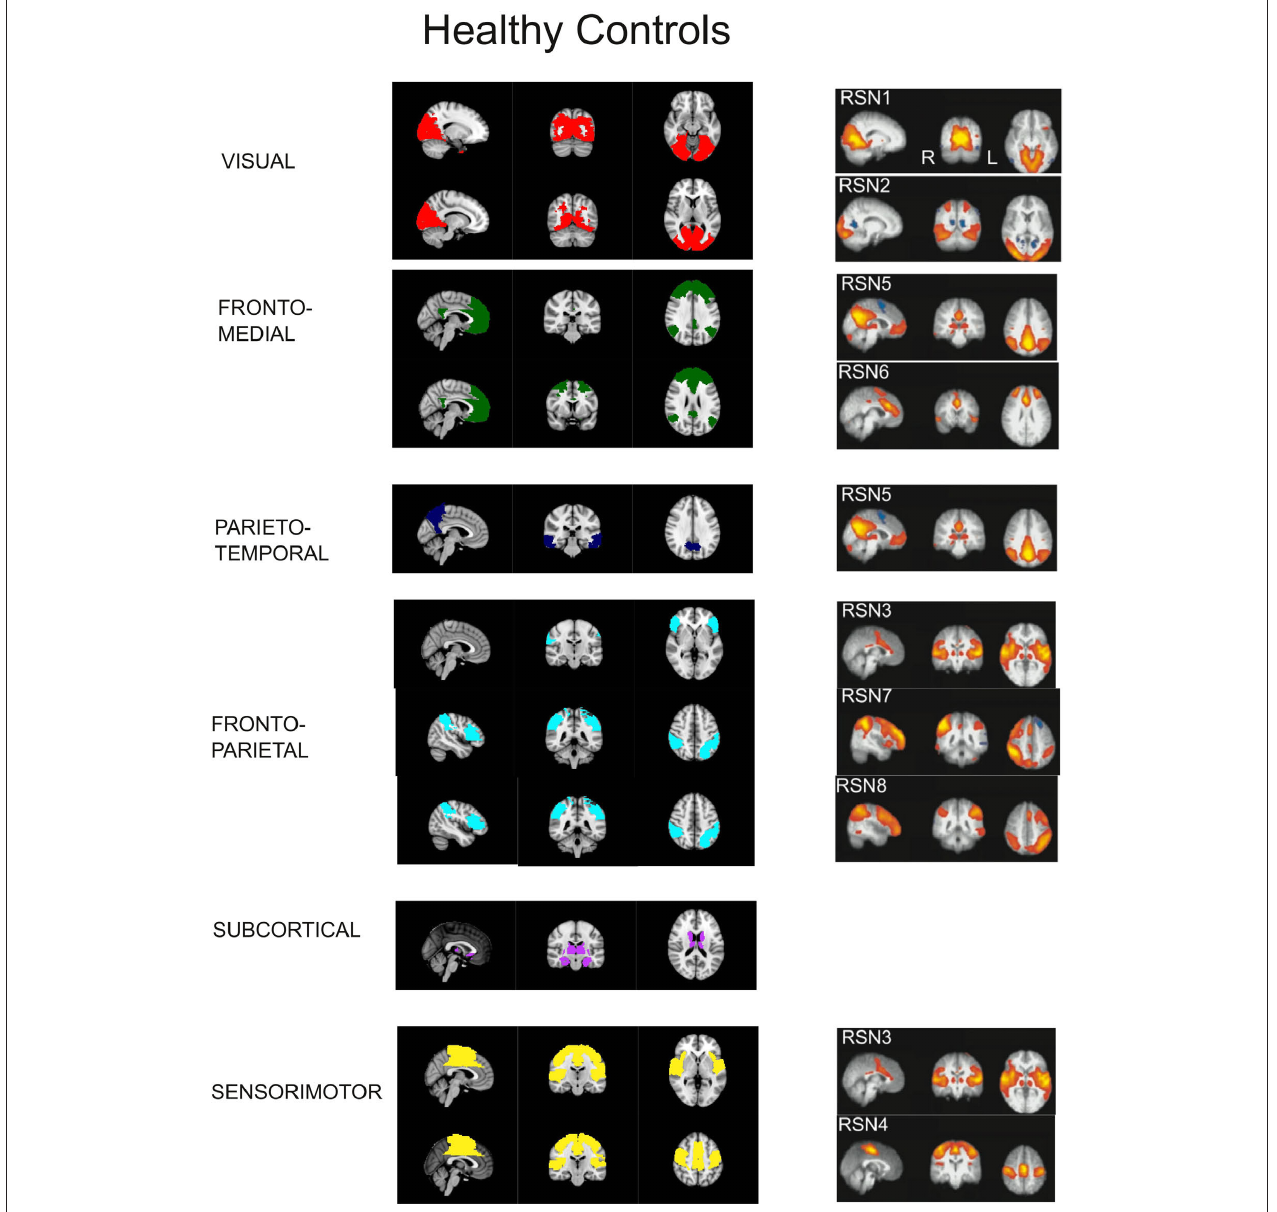
(default mode network), RSN6 (executive control), RSN7 (right dorsal visual stream), RSN8 (left dorsal visual stream). Coordinates used are: RSN1, x = 17 y = − 73 z = − 12; RSN2, x = − 13 y = − 61 z = 6; RSN3: x = 3, y = − 17, z = 1.5; RSN4, x = 1, y = − 21, z = 51; RSN5, x = − 4, y = − 29, z = 33; RSN6, x = 5, y = 6, z = 27; RSN7, x = 45, y = − 42, z = 47; RSN8, x = − 45, y = − 42, z =